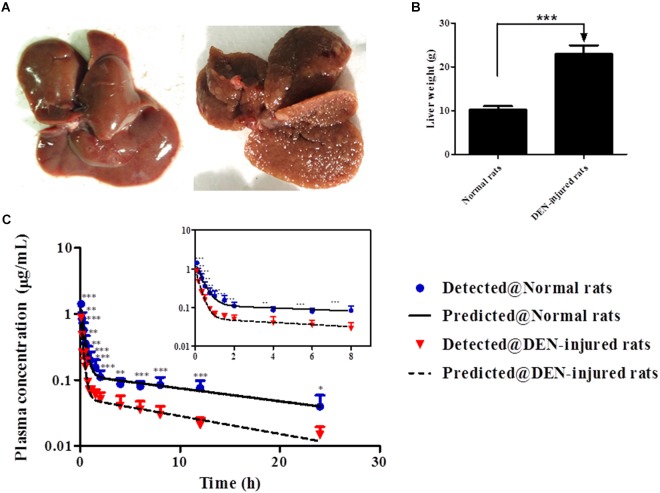
(A) After treated with normal saline or DEN for 14 weeks, the liver tissues were collected. (B) The liver weight of normal and DEN-injured rats. (C) Mean plasma concentrations in each time point of cinobufotalin after i.v. injection (2.5 mg/mL) in normal rats and DEN-injured rats, and the internal panel plot represented the data of first 8 h. Each point is shown as the average concentration and standard deviations (n = 6). ∗p < 0.05, ∗∗p < 0.01, and ∗∗∗p < 0.001.